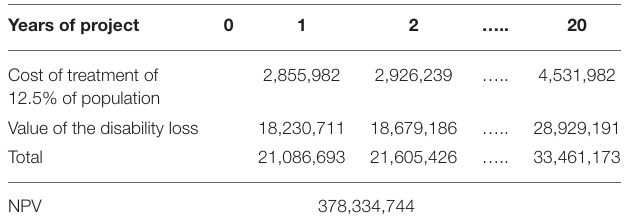
TABLE 8 | S-SRV population protection and compensation for disability loss due to schistosomiasis, in US dollars. Years of project